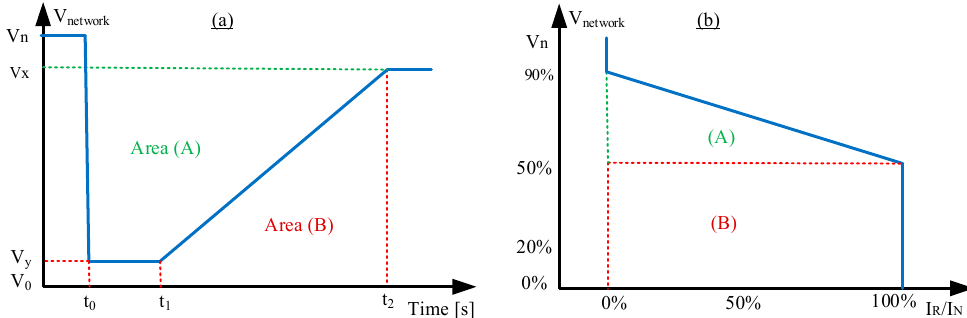
Figure 2. Low voltage ride-through (LVRT) requirements during voltage sag: ( a ) general curve limits and ( b ) reactive current support.